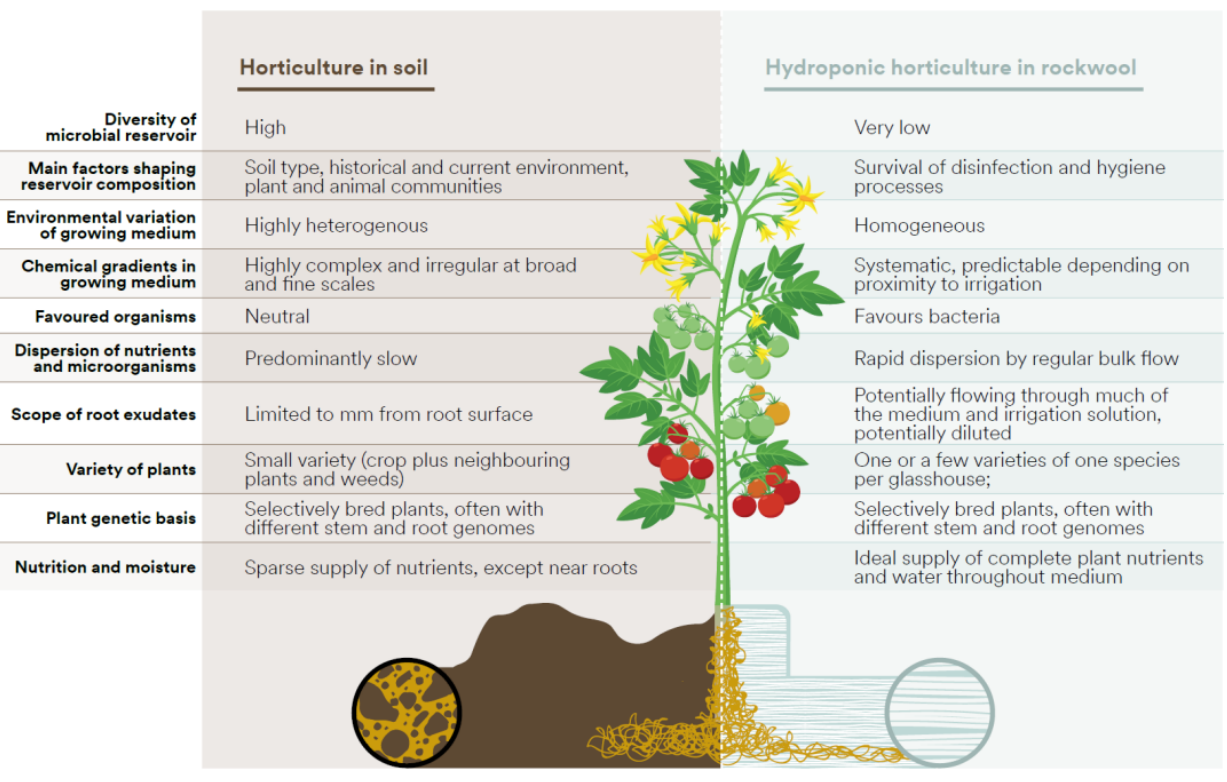
Figure 1. Comparison of broad features of soil and hydroponic rockwool environments in horticul- tural systems which affect the ecology of the root zone.